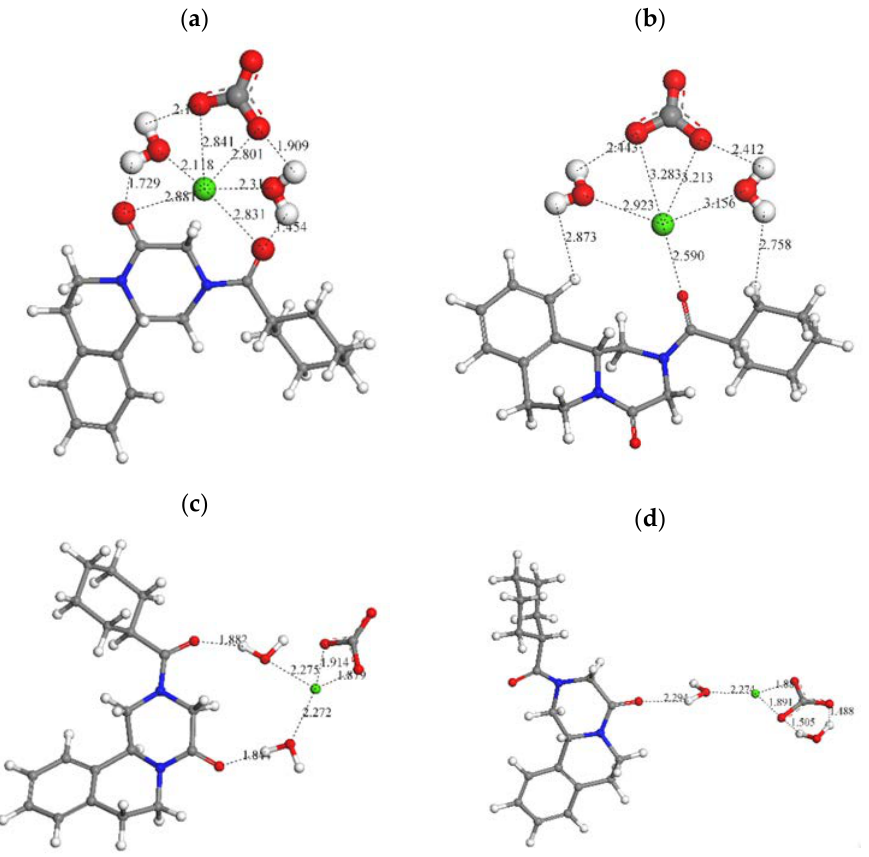
Figure 2. Possible complexes of PZQ molecule conformer syn ( a ) and anti ( b ) with hydrated Ca 2+ carbonates clusters, and optimized complexes of syn ( c ) and anti ( d ) PZQ (non-bonding distances are included in Å). The C, Ca, H, N, and O atoms are in grey, green, white, blue, and red color.